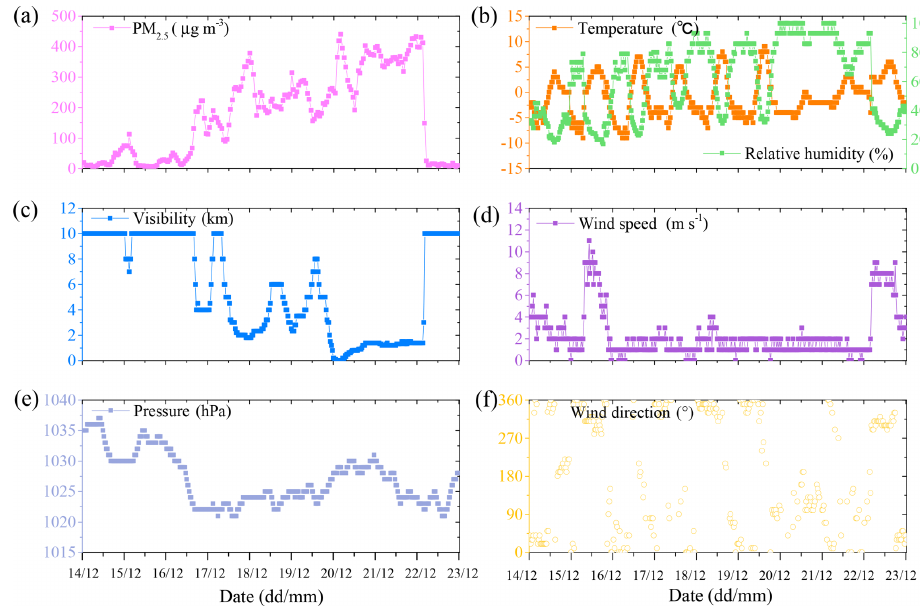
Figure 2. Time series of ground level PM 2 . 5 (a) , relative humidity and temperature (b) , visibility (c) , wind speed (d) , surface pressure (e) , and wind direction (f) from 14 to 22 December 2016. The units for these meteorological parameters are as follows: micrometers per cubic meter, percentage, degrees Celsius, kilometers, meters per second, hectopascals and degree,